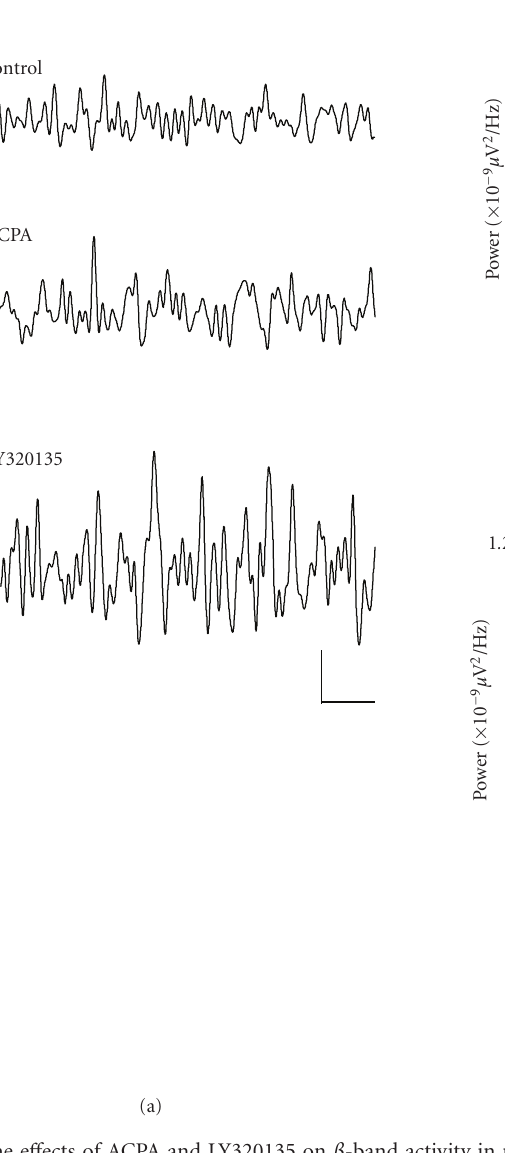
Figure 4: The e ff ects of ACPA and LY320135 on β -band activity in mEC layer V. (a) Example traces from layer V showing β -oscillations under conditions in which ACPA (10 μ M) or LY320135 (500nM) were applied. (b) Plot of power spectral density during drug application (filtered between 2–100 Hz). Control (black line), ACPA (red line), LY320135 (blue line). (c) Similar plot to (b) bandpass filtered between 15–29 Hz. Scale bar = 200 milliseconds × 50 μ